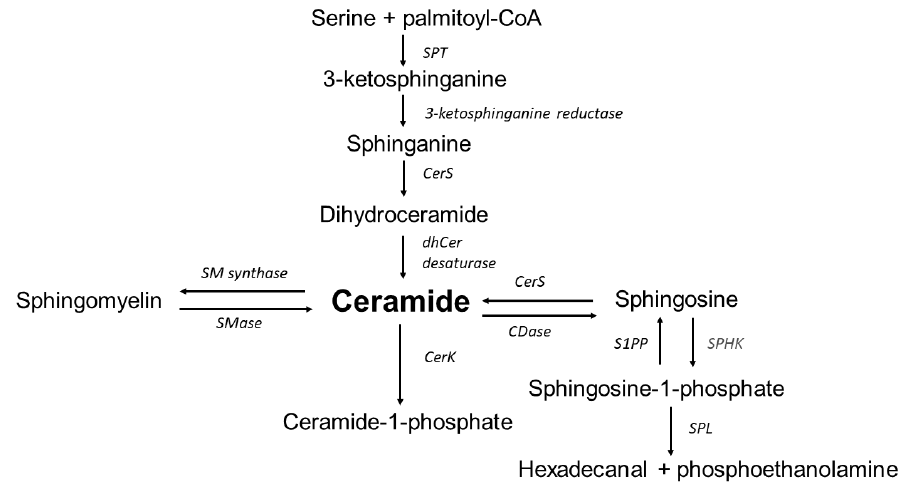
Figure 1. Overview of sphingolipid metabolism. SPT—serine palmitoyltransferase, CerS—ceramide synthase, dhCer desaturase—dihydroceramide desaturase, CerK—ceramide kinase, S1PP—sphin-